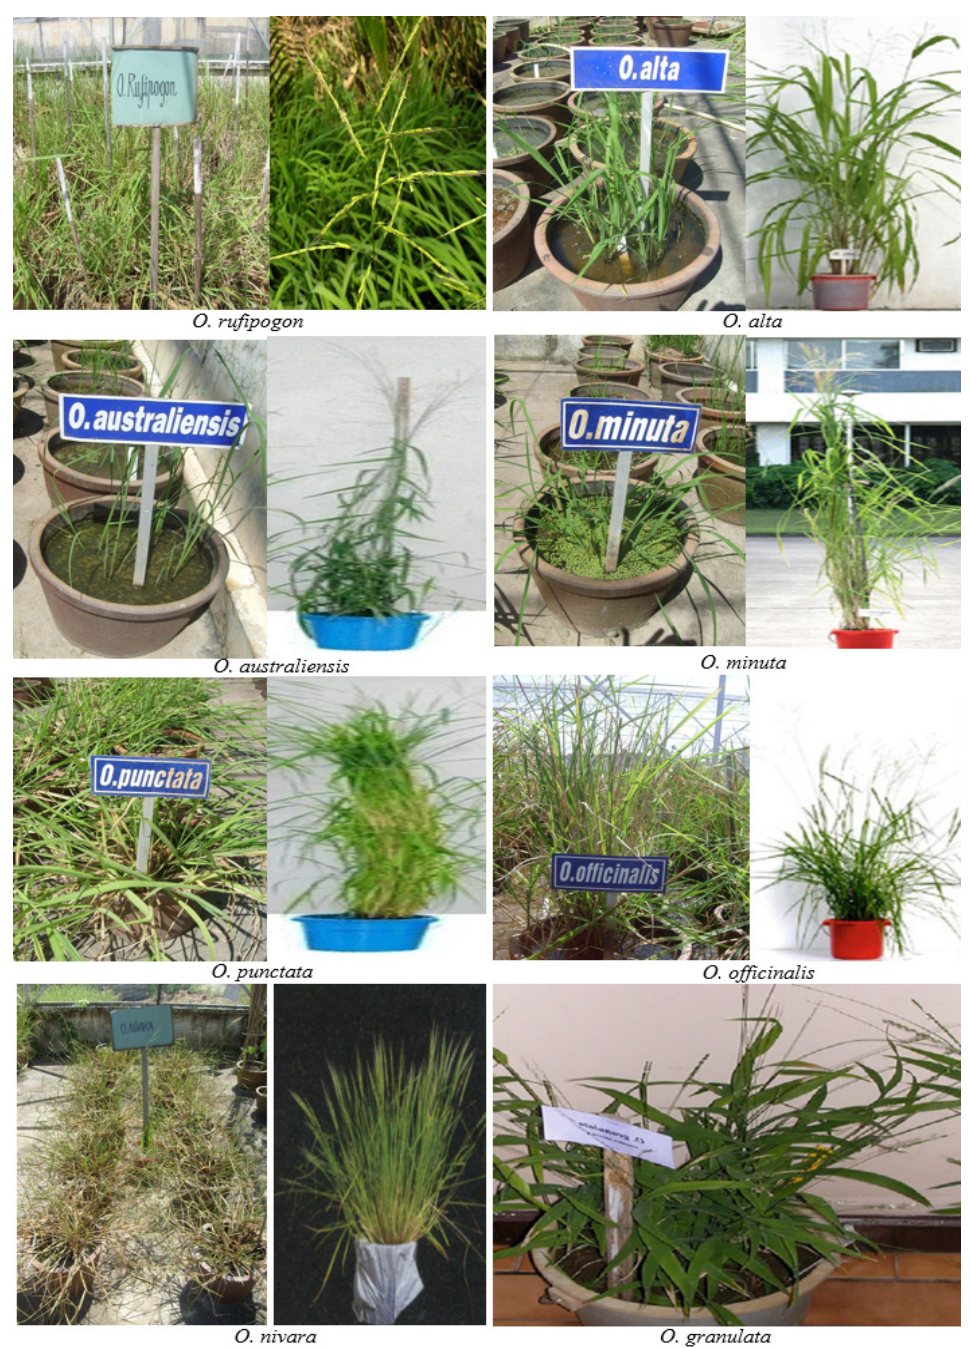
Figure 2. Some wild species of Oryza available in Vietnam. The photos were collected by some scientists [34–37]. The photo of O. granulata was taken by Dr. Rod A. Wing (IRRI).